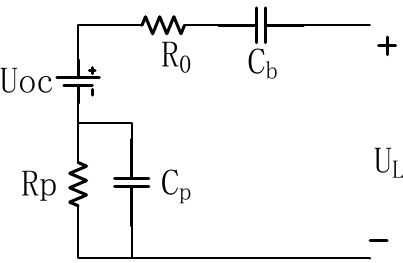
Figure 2. Partnership for a new generation of vehicles (PNGV) model.